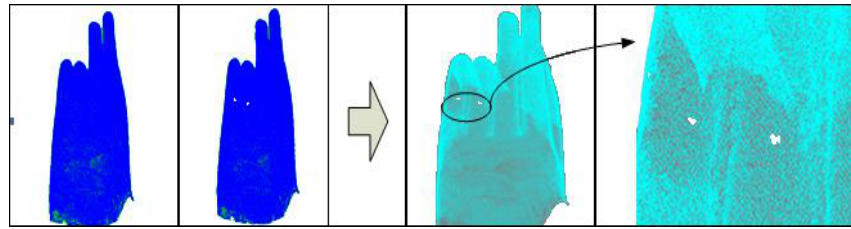
Figure 18. Results of data obtained from the first and second time (the white region is the suspected damaged region).